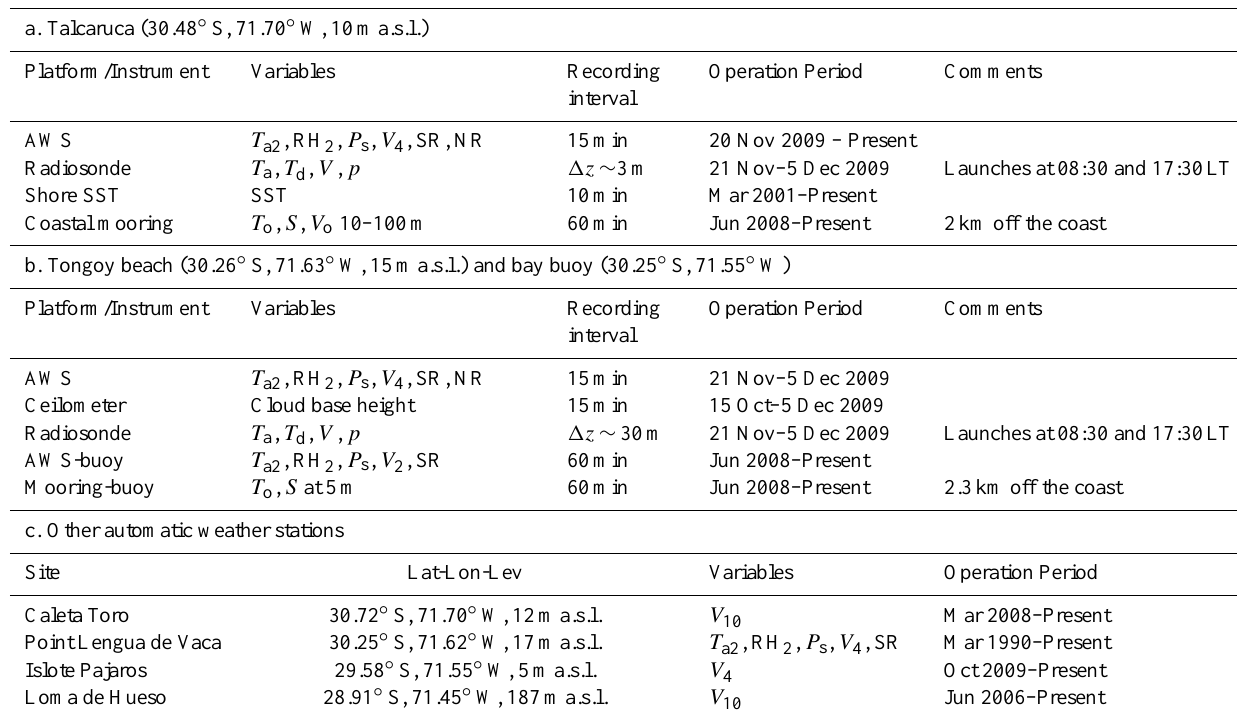
Table 3. Platforms and instrument available during